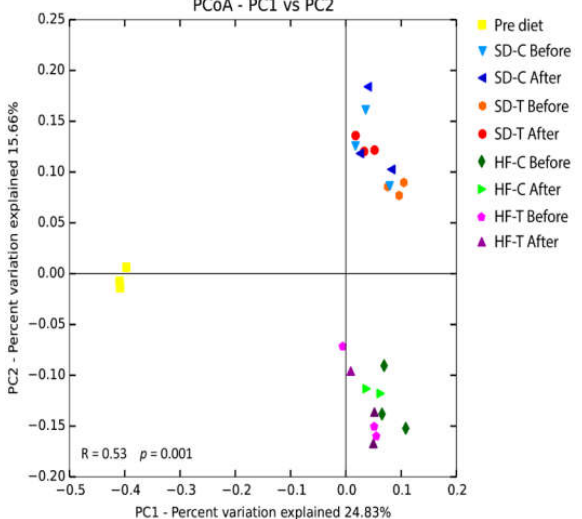
Figure 6. Effect of diets on the bacterial community. The PCoA of unweighted UniFrac distances was generated with the sequences obtained by the samples in the pre-diet (absolute control), and before and after training periods. The ANOSIM similarity analysis results show significant alteration of the gut microbiota by the diets.